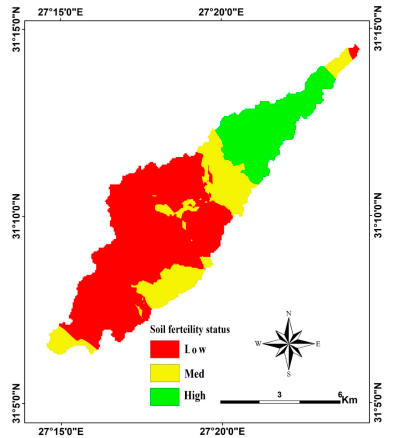
Figure 6. Spatial distribution of soil fertility in Wadi between high, moderate, and low